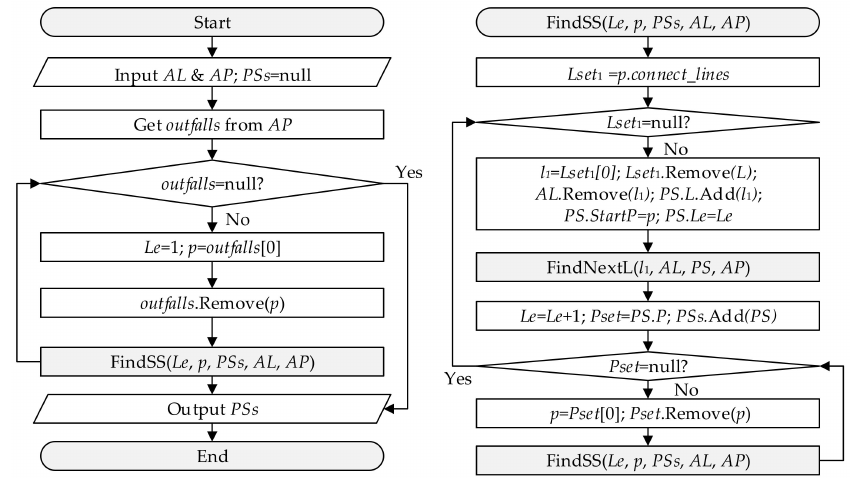
Figure 2. Algorithm program flowchart for pipe strokes construction.